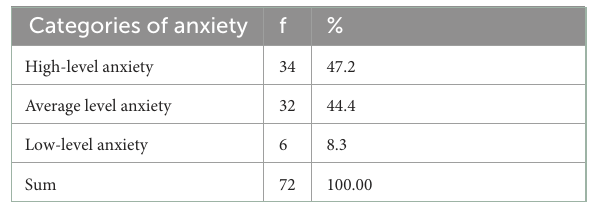
TABLE 1 Participants’ percentages and numbers according to anxiety